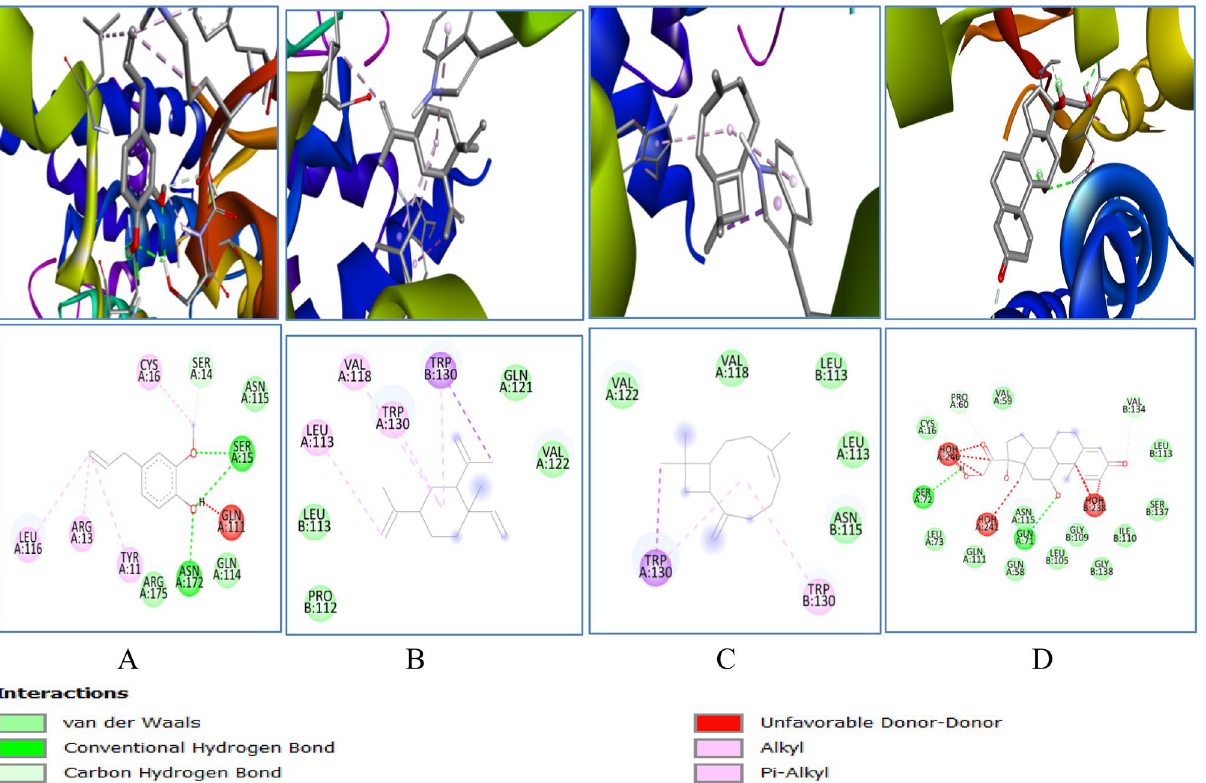
Figure 14. 3D (to the upper panel) and 2D (to the lower panel) interaction diagrams of ( A ) Eugenol, ( B ) Cyclohexane ( C ) Caryophyllene ( D ) Prednisolone with the crystal structure of Glutathione − S − Transferase (PDB ID: